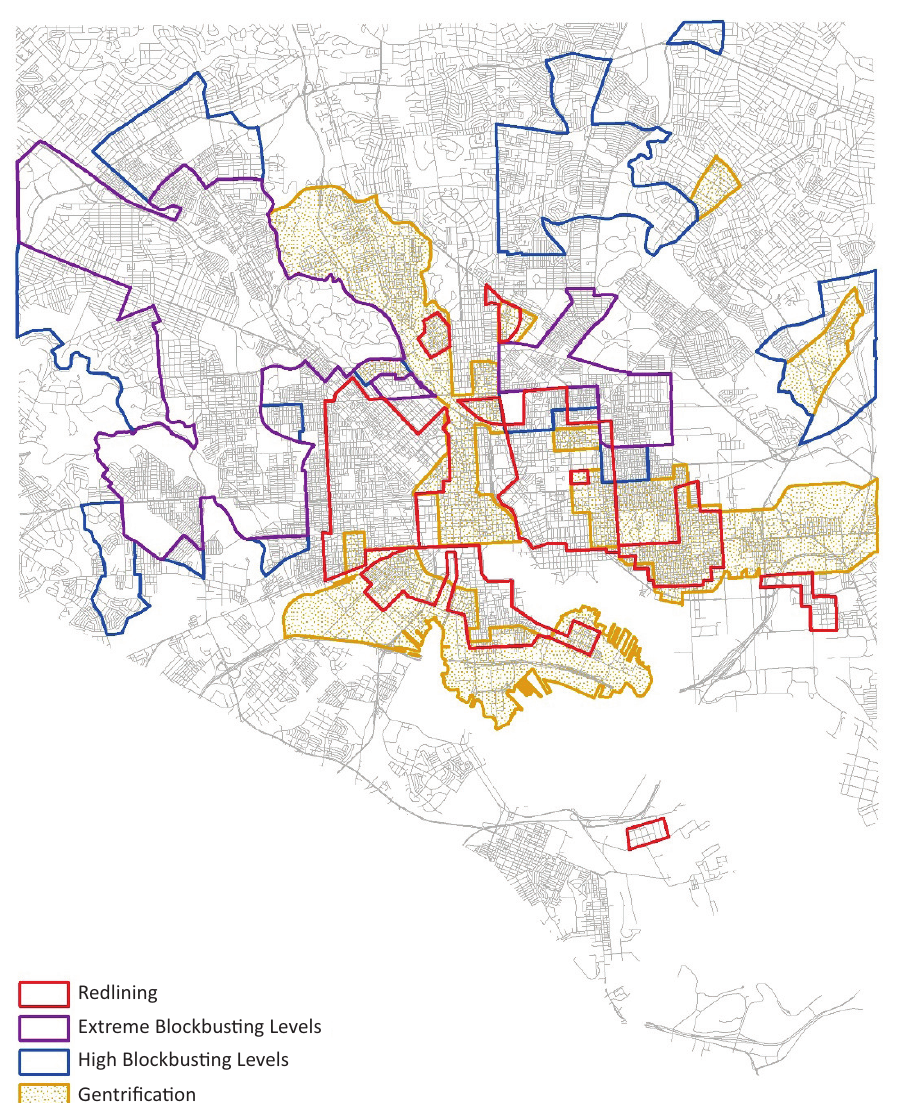
Figure 1. Map of Baltimore illustrating locations of inequitable housing practices. and appended characteristics from that neighborhood to the